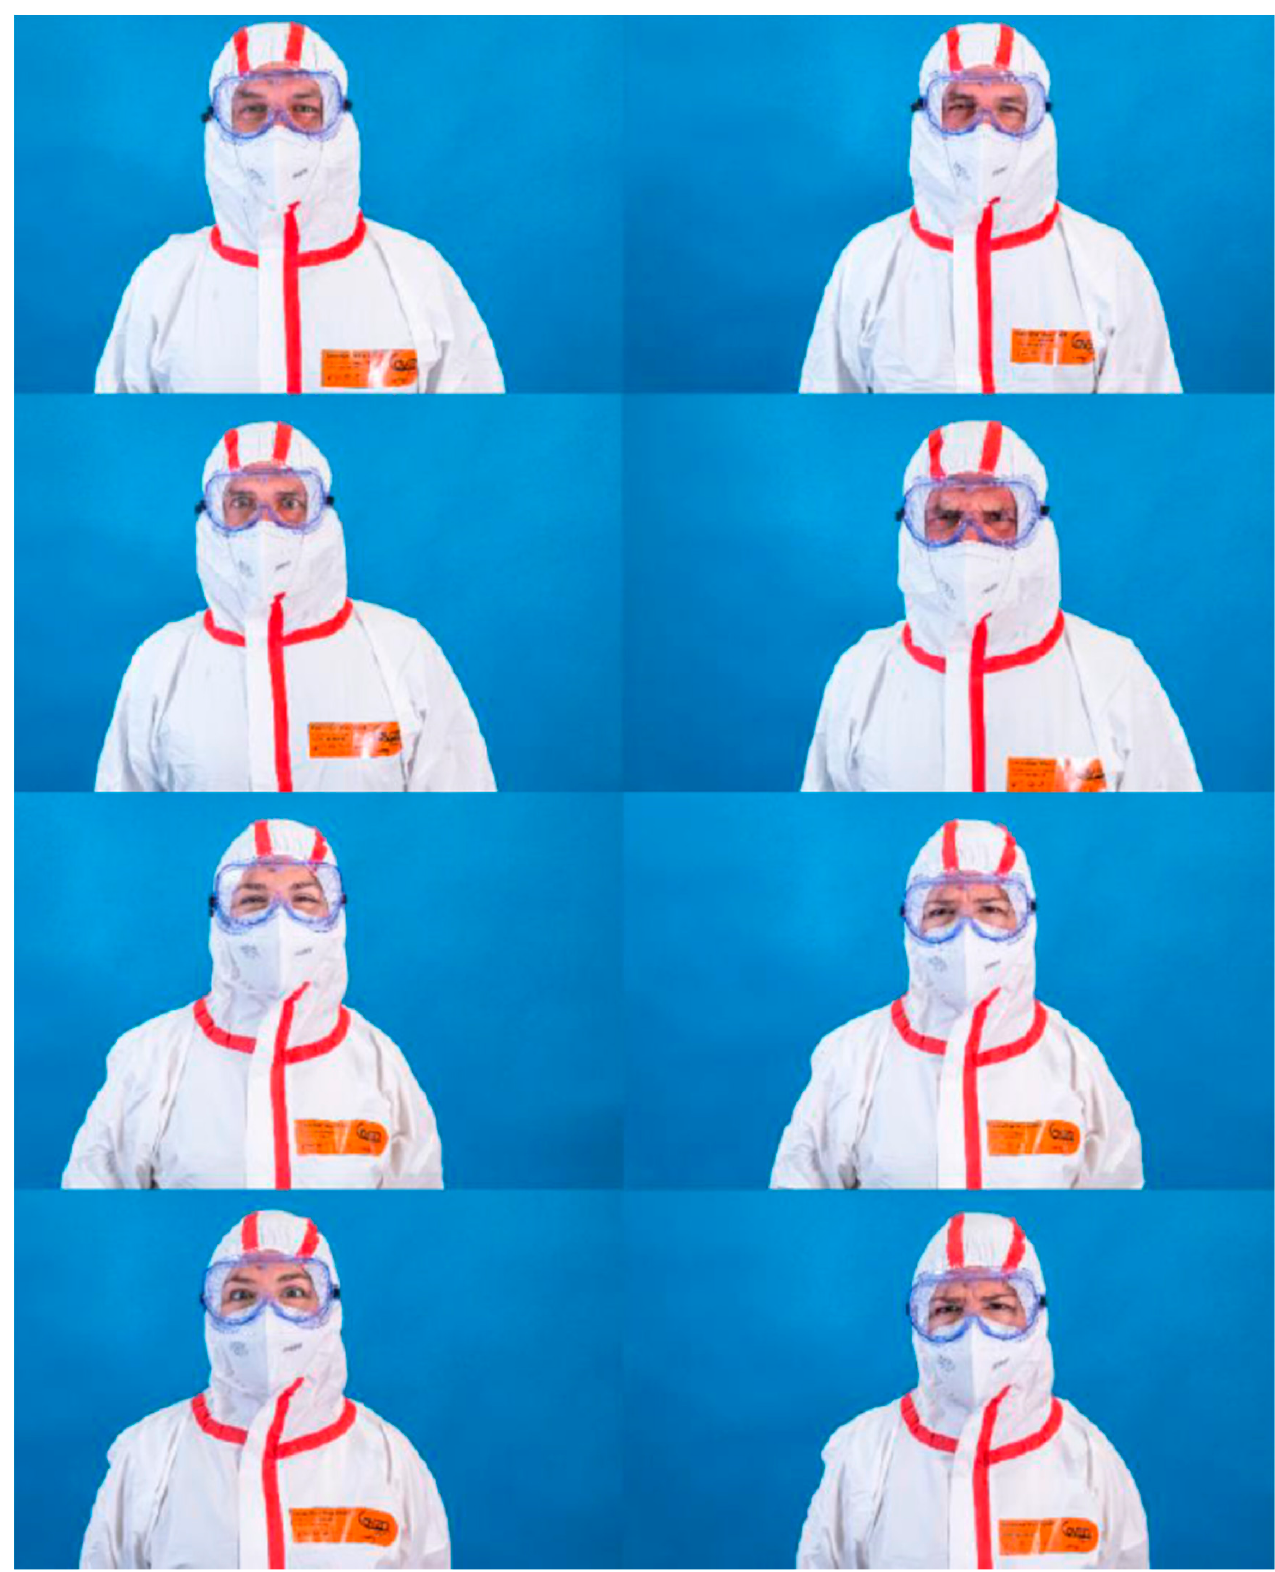
Figure 3. Photographs of the four emotions by an actress and an actor wearing protective overalls (PO)/body, mask and protection goggles (from left to right: happy; sad; fear/surprise; and disgust/anger).